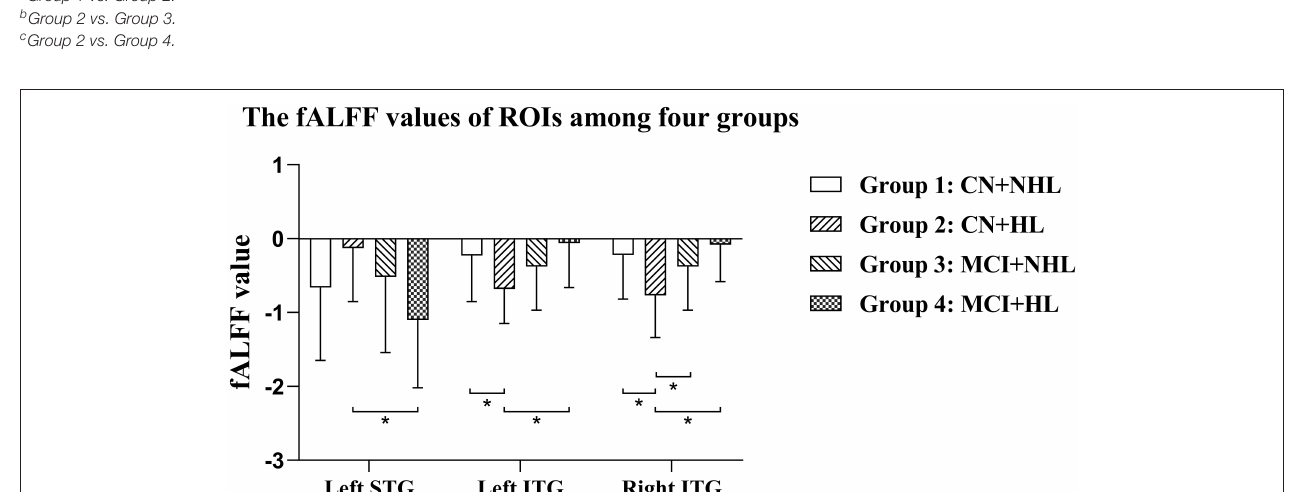
FIGURE 3 | Specific differences in fALFF values in three brain regions among four groups. Left STG, the left superior temporal gyrus; Left ITG, the left inferior temporal gyrus; Right ITG, the right inferior temporal gyrus. *Means statistical significance level of p < 0.05/6, Bonferroni.